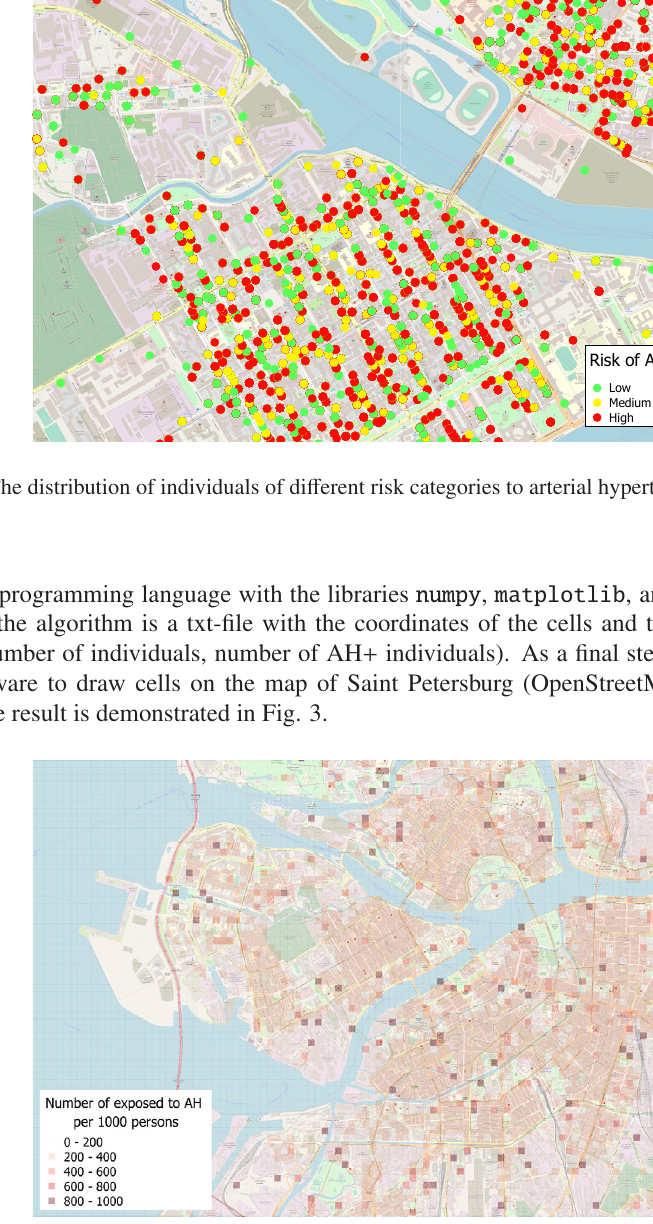
Figure 3. Density of the individuals exposed to arterial hypertension in the cells with size 250m x 250m